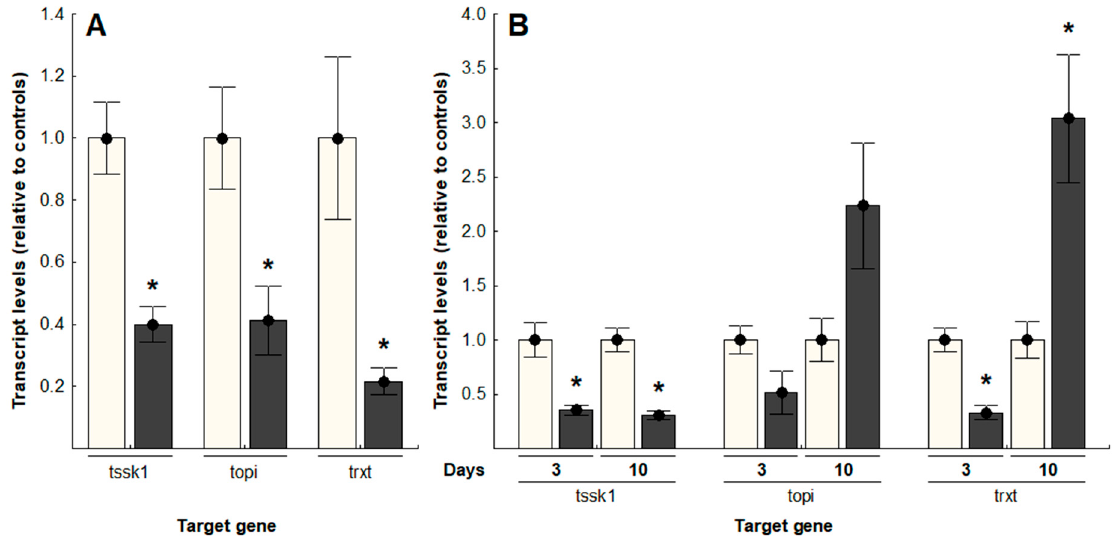
Figure 2. Transcript levels of tssk1 , topi and trxt , relative to controls, in Bactrocera tryoni testes after dsRNA delivery: ( A ) Injected dsRNA; ( B ) Orally delivered dsRNA. Values represent the means (bars) and the 96% standard errors (whiskers) of 10 biological replicates; asterisks indicate significant differences, t -test, p < 0.05 (White bars: Negative controls, grey bars: gene-specific dsRNA treatments).